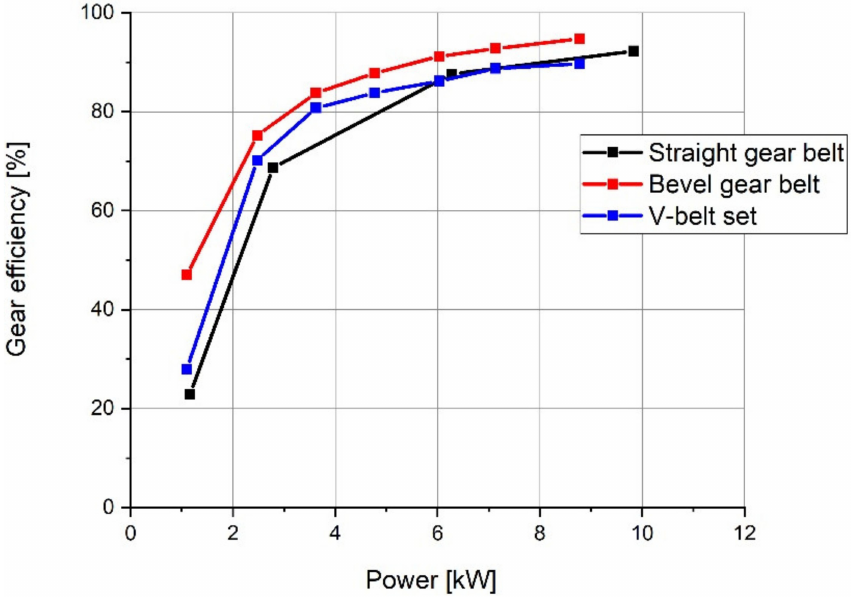
Figure 5. Selected belts e ffi ciency diagram, data acquired during laboratory tests. Energy losses occurring in toothed gears, rolling bearings and sealing are di ffi cult to estimate. They depend on a machines’ technical condition, temperature and type of lubricating agent. Therefore, a 96% appropriate overall gear and bearing e ffi ciency was used